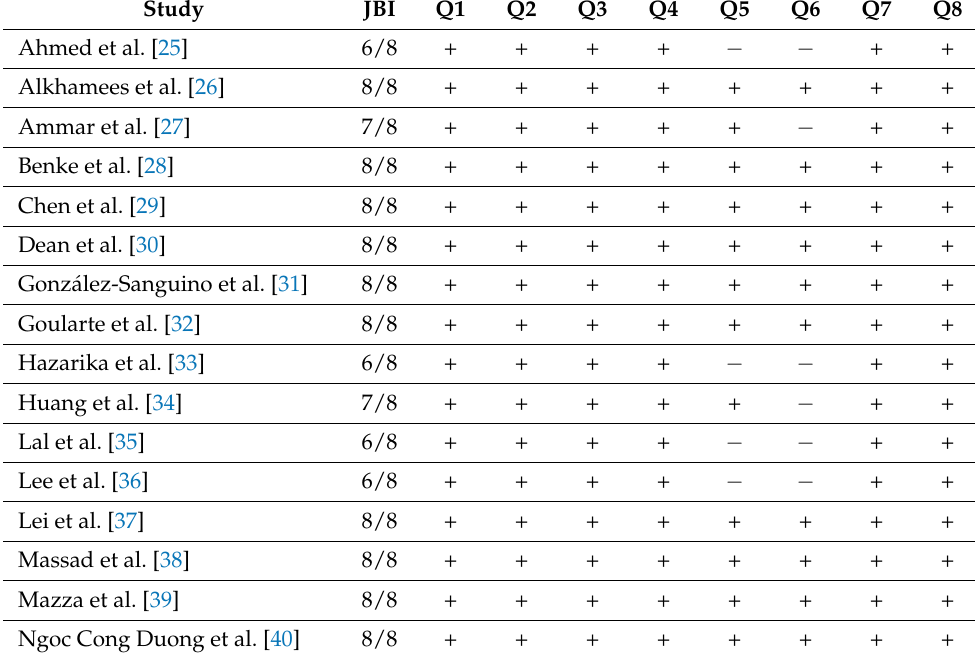
Table 5. The results of the quality assessment of cross-sectional quantitative